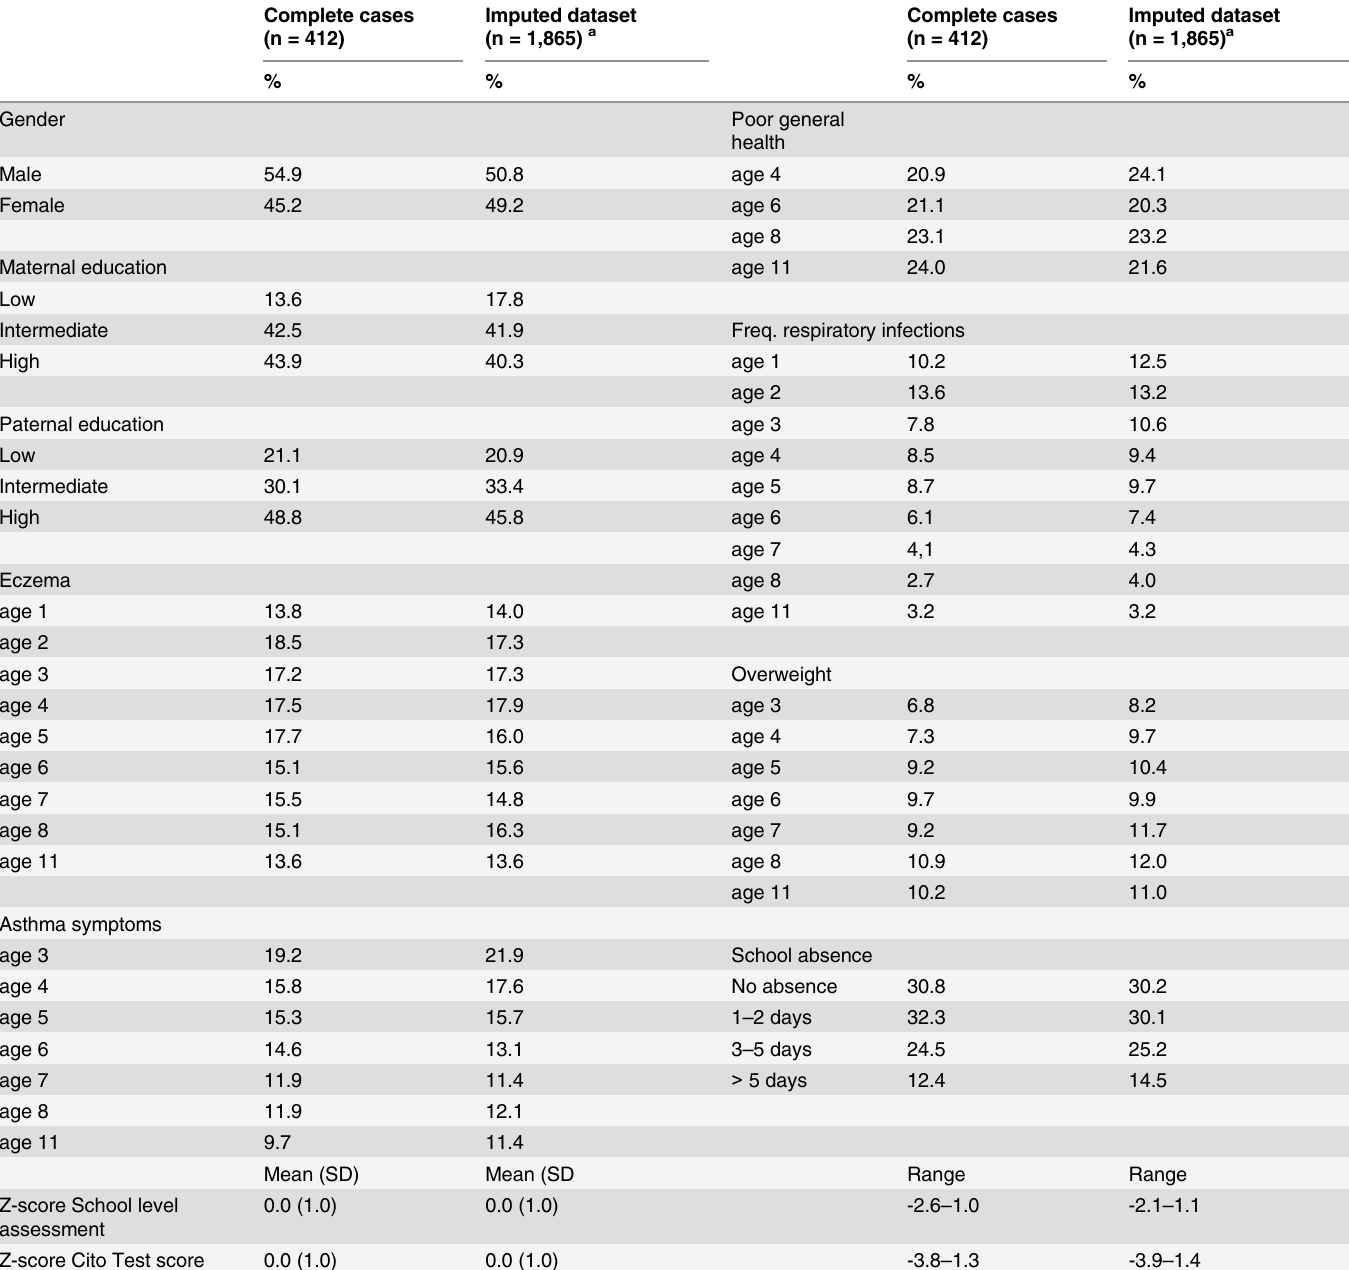
Table 2. Characteristics of the study population: original dataset versus imputed